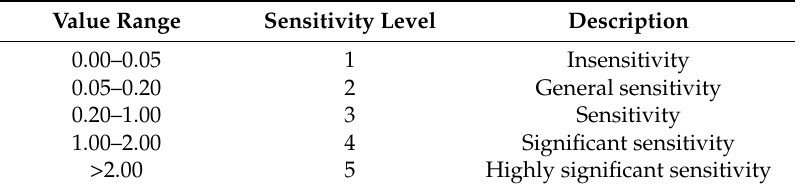
Table 2. Relationship between S factor value and parameter sensitivity.